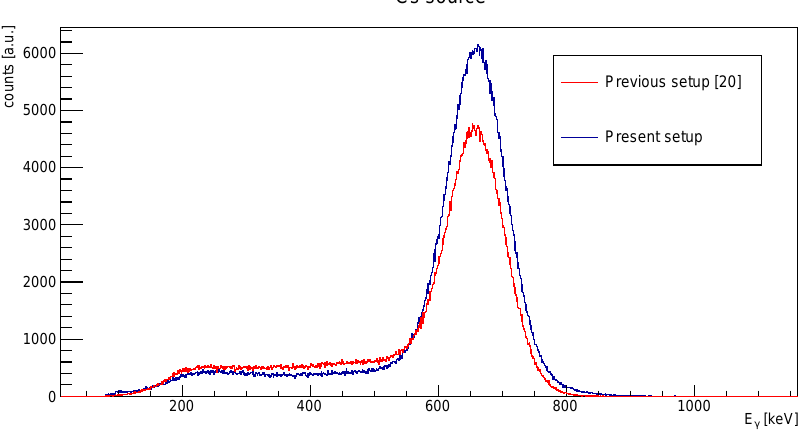
Figure 2: Comparison between 137 Cs spectrum simulated with present setup, blue line, and with previous setup, red